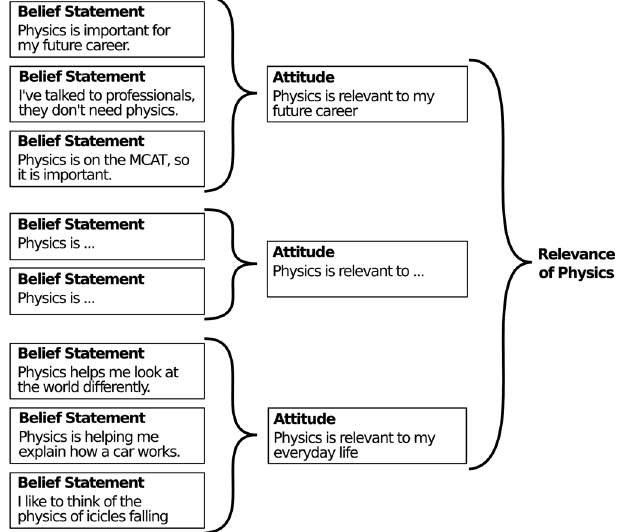
FIG. 1. A representation of relevance consisting of multiple attitudes and beliefs. This is not an exhaustive list of all beliefs and attitudes that help form a sense of relevance but serves to give an example of such an organization. Multiple beliefs are organized into attitudes. Multiple attitudes constitute a sense of relevance. Belief statements are used to infer beliefs in this structure as they are the most readily accessible to researchers measuring students ’ beliefs. This organization of relevance aligns with (i) the structure of previous survey measures of relevance in PER and (ii) Rokeach ’ s theoretical organization of